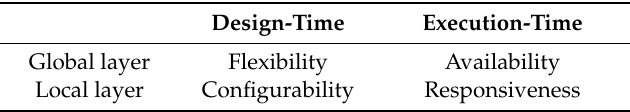
Table 3. Leading drivers for cloud